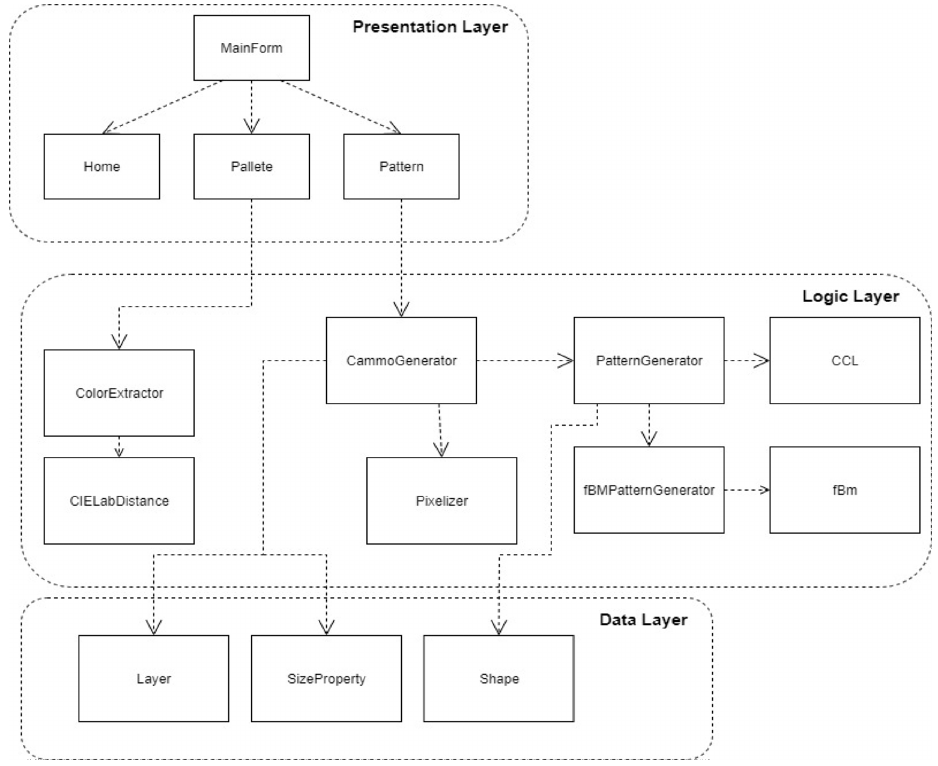
Figure 9. The architecture of CammoGenerator